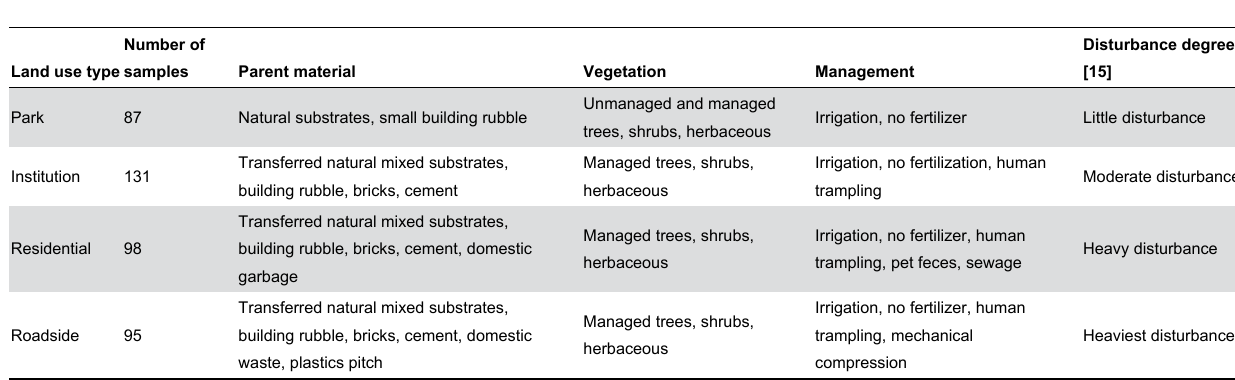
Table 2. Characteristics of the four land use types.